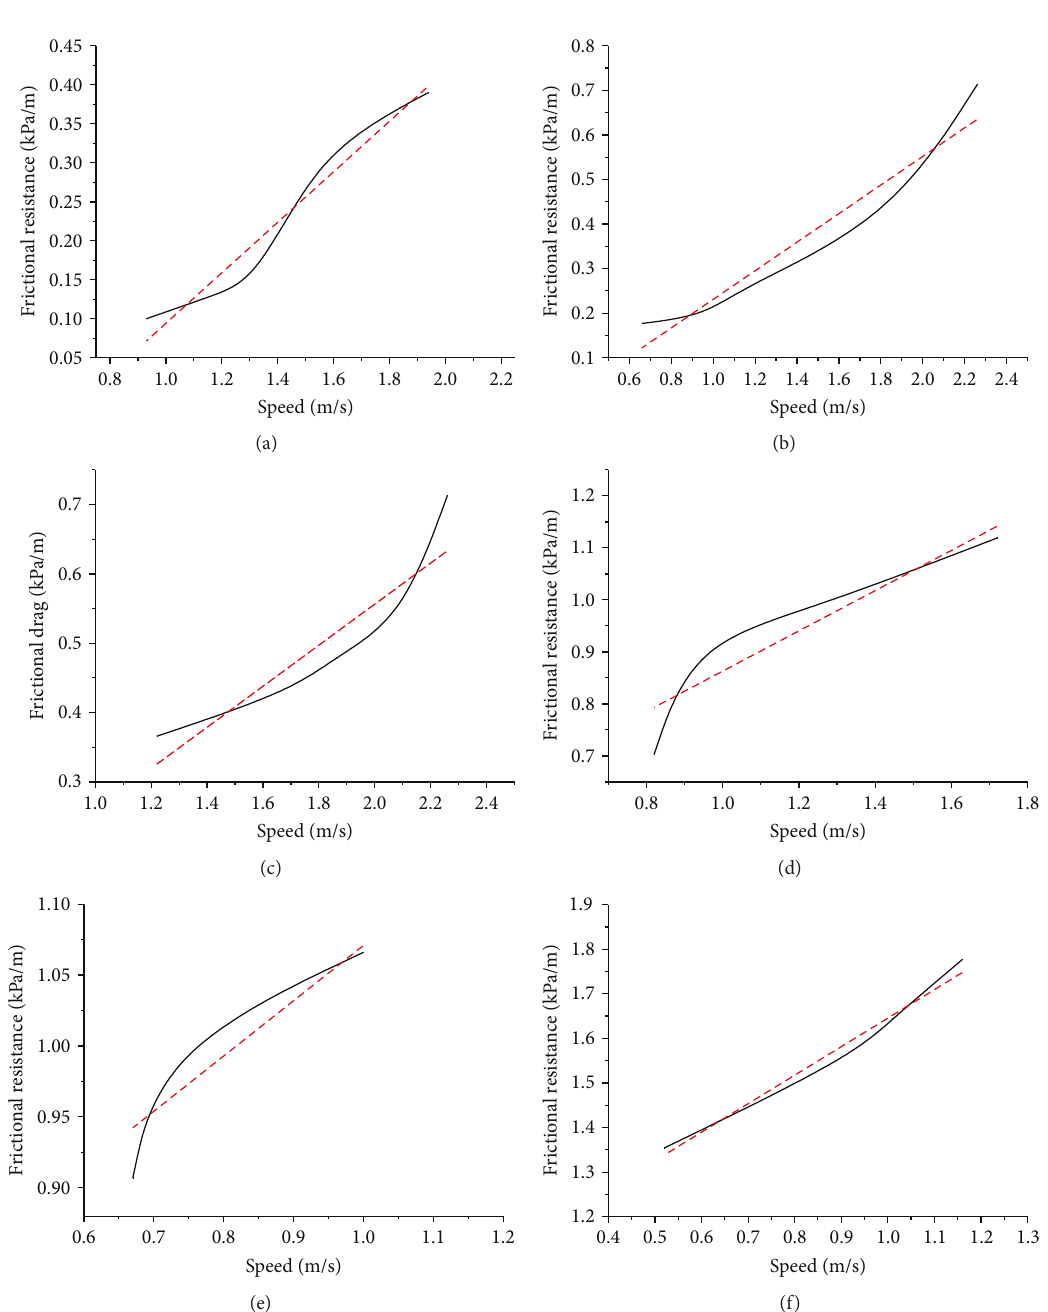
Figure 12: Relation curve of on-way resistance and PGBS speed in di ff erent back fi ll concentrations. Graphs in (a – f) indicate the PGBS concentrations of 62%, 64%, 65%, 66%, 67%, and 68%,